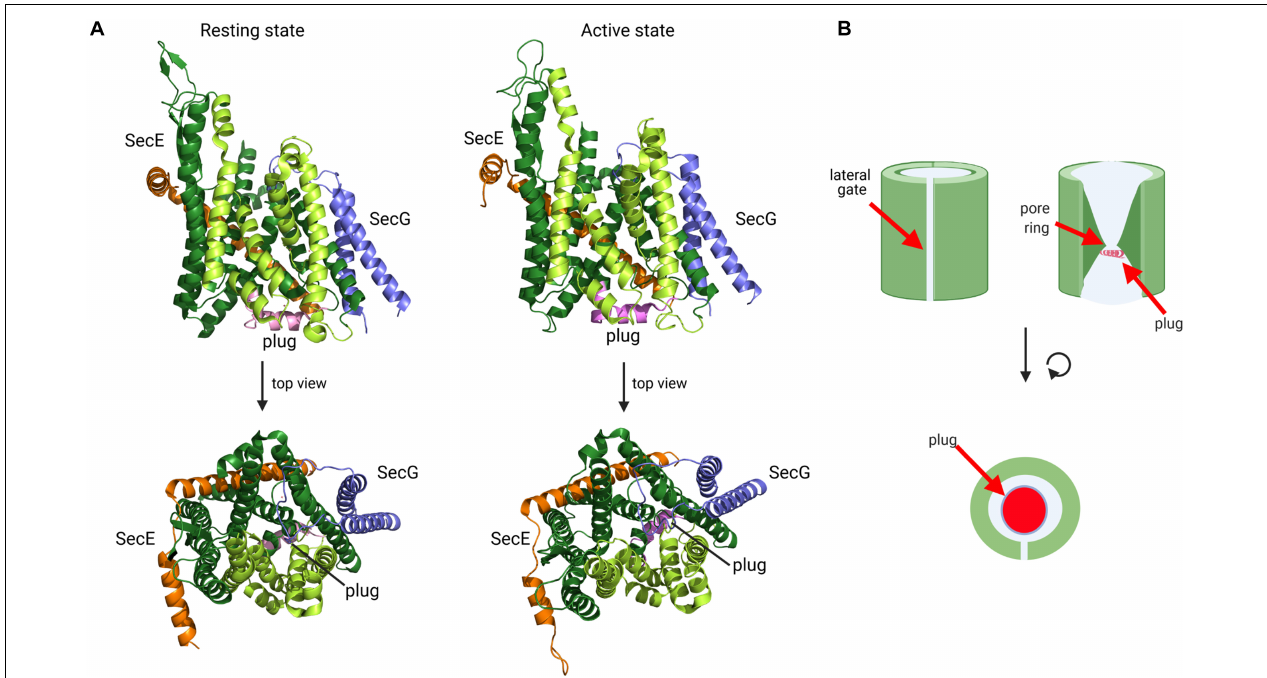
FIGURE 6 | Structure of the SecYEG translocon in its resting state and active state. (A) Structure of T. thermophilus SecYEG in the resting state (PDB 5AWW) and the active state (PDB 5CH4). SecY is shown in green, SecE in orange and SecG in blue. The SecY transmembrane domains that constitute the lateral gate are shown in light green and the plug in magenta. The upper structures depict the front views of the SecYEG translocon and the lower structures the top view from the cytosol, respectively. (B) Schematic front view and view from the cytosol of the SecYEG